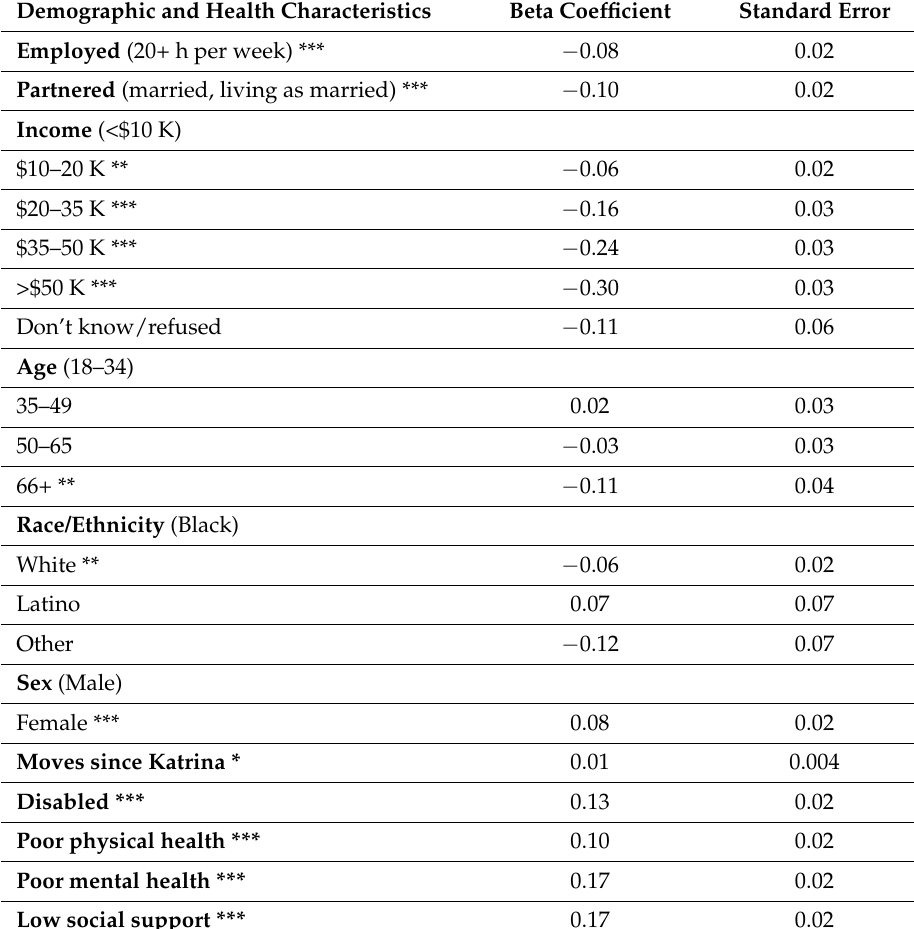
Table 3. Bivariate association between demographic characteristics and health status with food insecurity over time